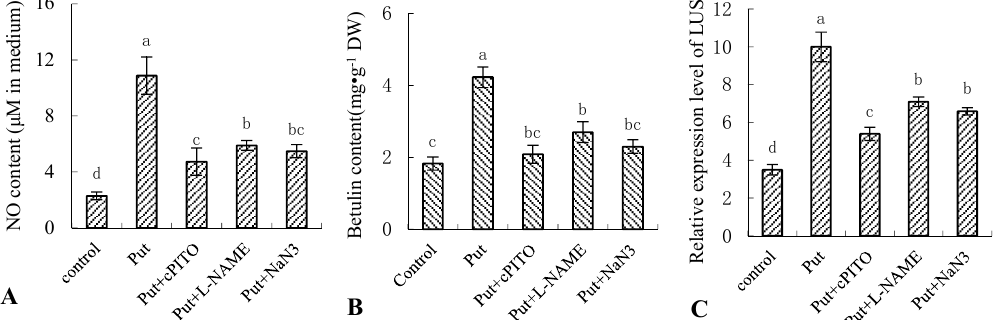
Figure 4. Effect of Put and NO inhibitor on NO production, betulin content, and gene expression of LUS in birch suspension cells. Eight-day-old suspension cells pretreated for 0.5 h with 150 μmol·L −1 2-(4-carboxyphenyl)-4,4,5,5-tetramethylimidazoline-1-oxyl-3-oxide (cPTIO; a NO-specific scavenger), 0.5 mmol·L −1 NR inhibitor sodium azide (NaN 3 ), and 3 mmol·L −1 NOS inhibitor N G -nitro-L-Arg methyl ester (L-NAME) were treated with 1 mmol·L −1 for 12 h, respectively. ( A ), NO content in culture medium of birch; ( B ), betulin content in suspension cells of birch; ( C ), gene expression of LUS in suspension cells of birch.